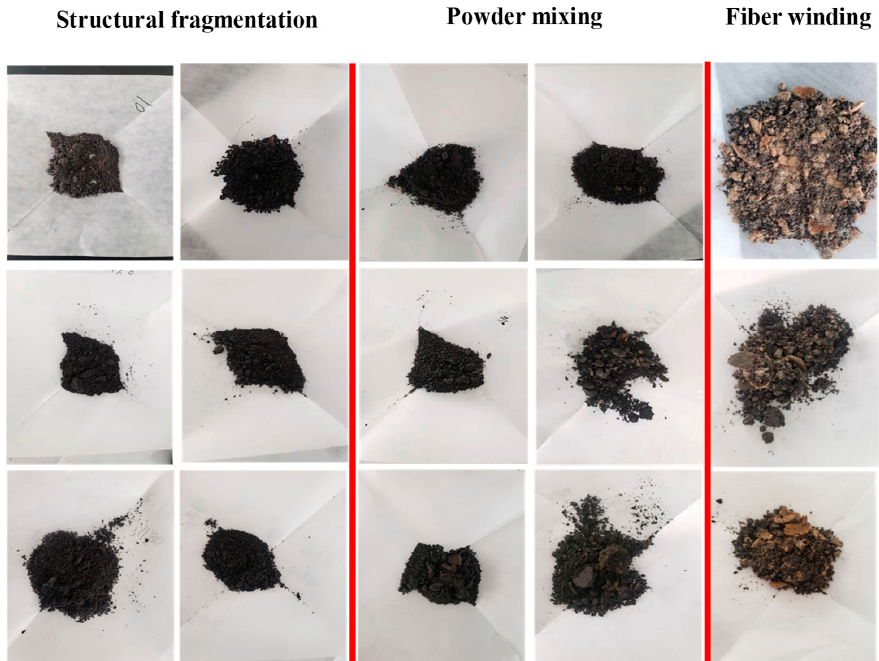
Figure 9. Solid phase at different cleaning stages.